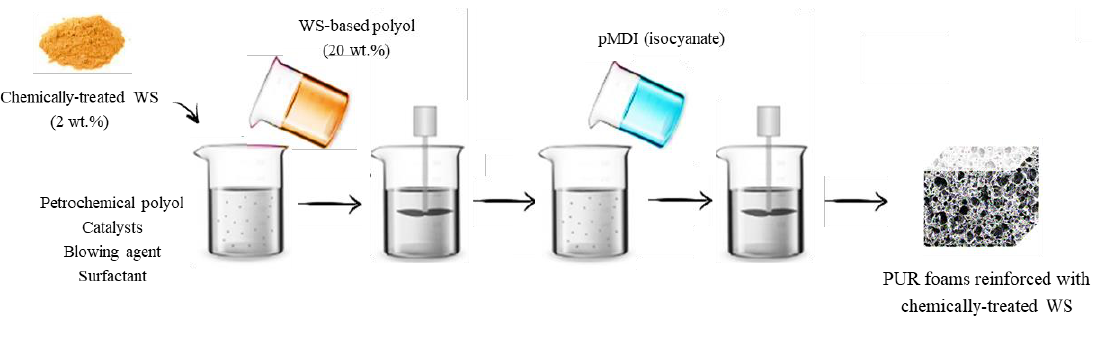
Figure 1. Schematic procedure of PUR foam synthesis.